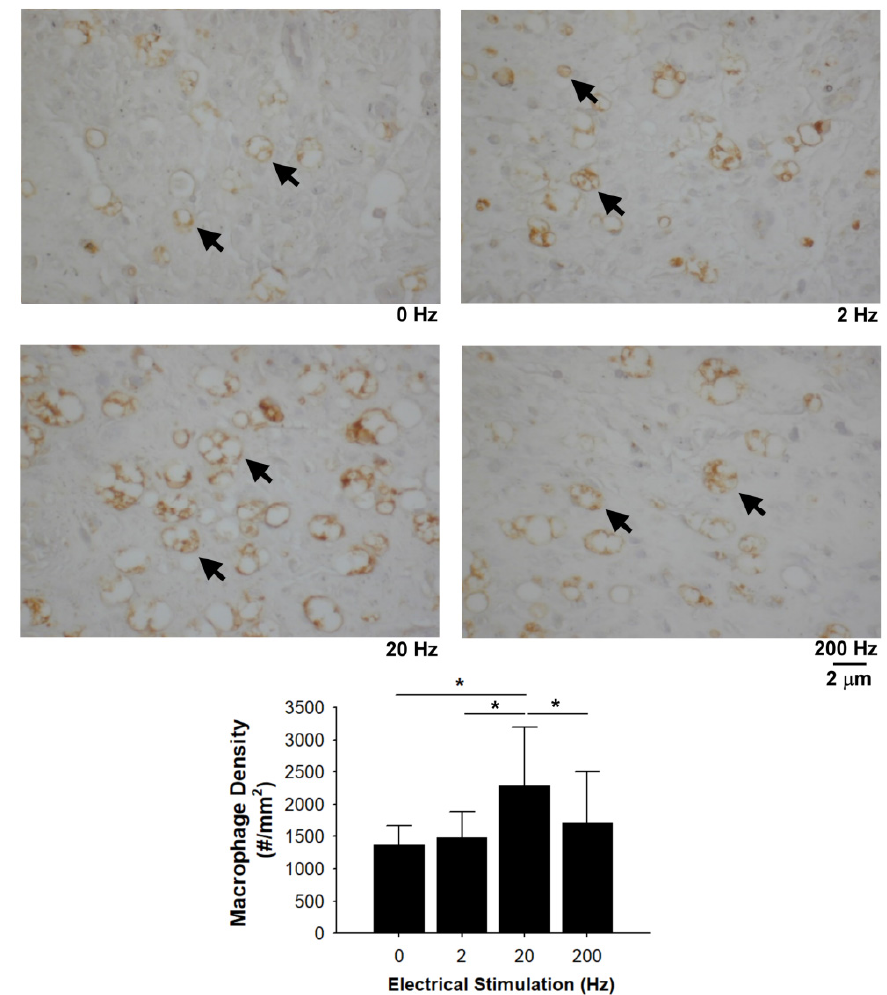
Figure 8. Effects of electrical stimulation on macrophage infiltration in taxol-treated rats. Representative images of the macrophages (arrows) and quantitation of macrophage infiltration. *Significant differences between conditions, P < 0.05. Scale bar = 2 μ m.